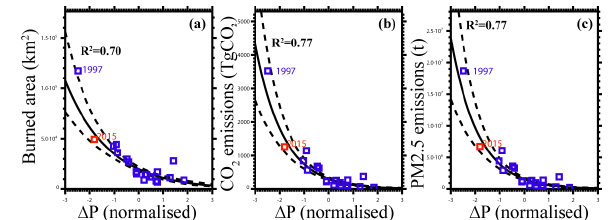
Figure 2. Empirical relationships between observed precipitation anomalies, burned area and fire emissions in the EA area between 1997 and 2016. The horizontal axes are the normalised June– November mean precipitation anomalies (no unit) of the GPCP. The vertical axes denote (a) burned area (km 2 ), (b) CO 2 emissions (TgCO 2 ) and (c) PM 2 . 5 emissions (t) of GFED4s. The year 2015 values are indicated by red squares. Solid and dashed lines indicate the best estimates and the 10%–90% confidence intervals of the fitting curves from Eq. (1),